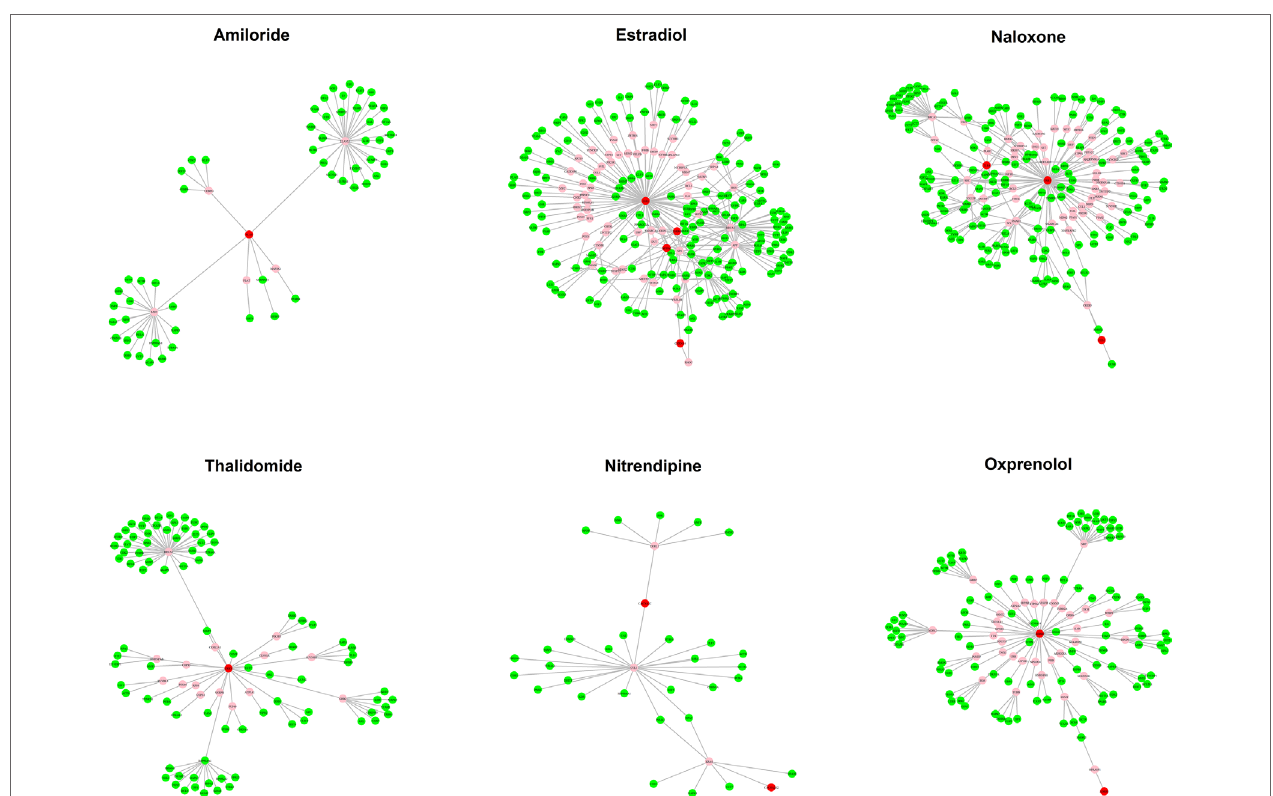
FIGURE 4 | The mode of action (MOA) network of ischemic cardiomyopathy (ISCM) candidates. Green nodes present known heart failure (HF)-related genes. Red nodes represent drug targets. Pink nodes represent genes with no evidence of corresponding to HF.